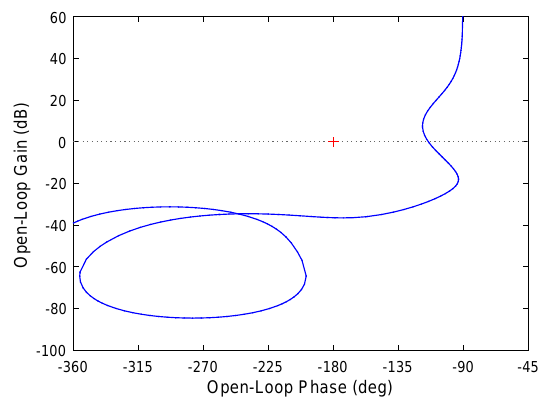
Figure 15: Nichols plot of the DFB feedback controller.